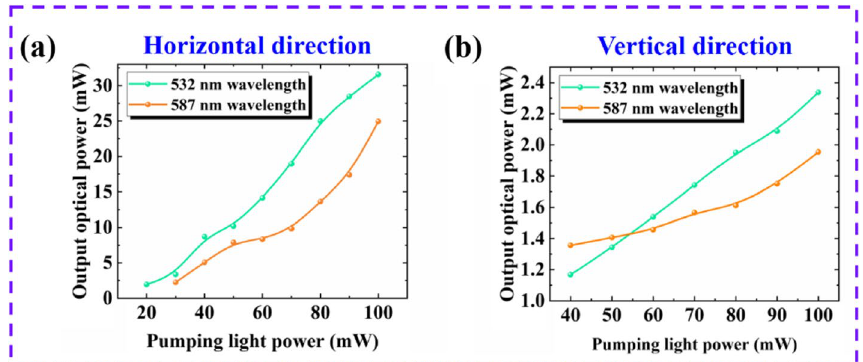
Fig. 7 The output power of both a horizontal and b vertical emissions for single-microdisk light source at 405 nm pumping light